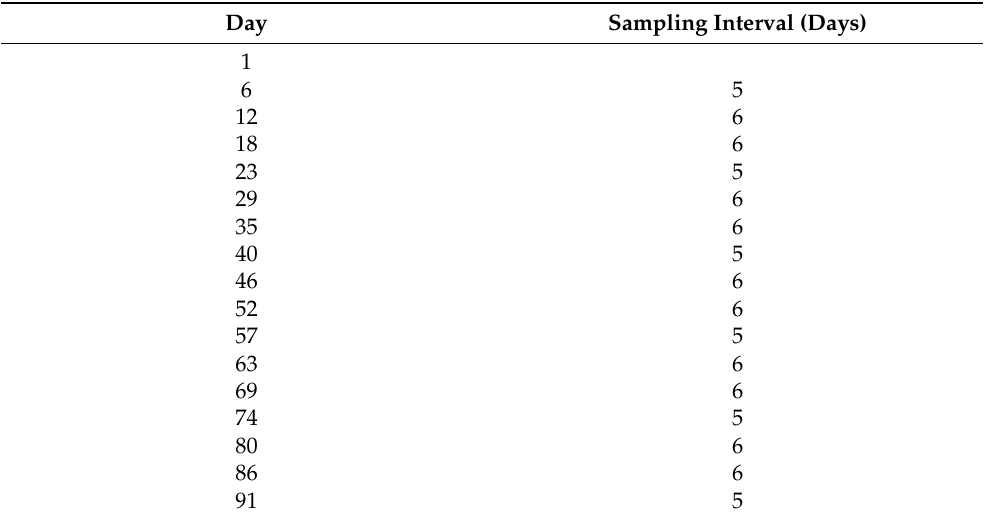
Table 1. Gas sampling intervals.